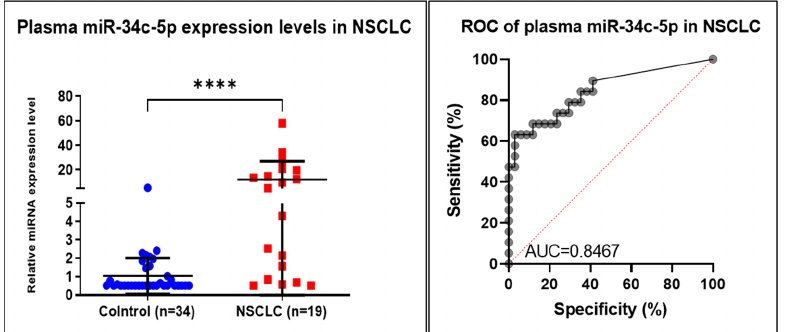
Figure 6. Plasma qRT-PCR data validation of the miR-34c-5p in NSCLC ( n = 19) and healthy controls ( n = 34), and receiver operating characteristic (ROC) curve AUC = 0.8467 (**** p ≤ 0.0001).